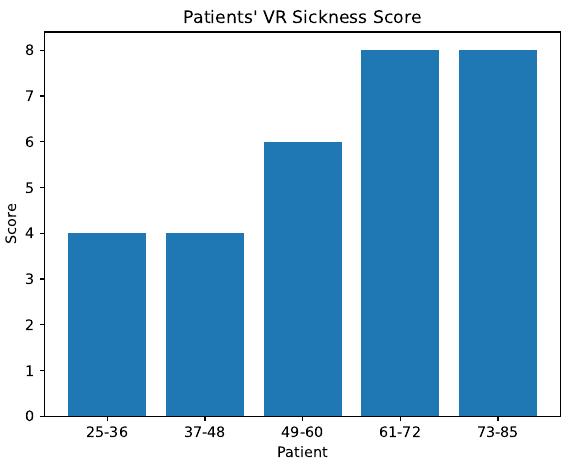
Figure 18. Sickness score provided by the patients.